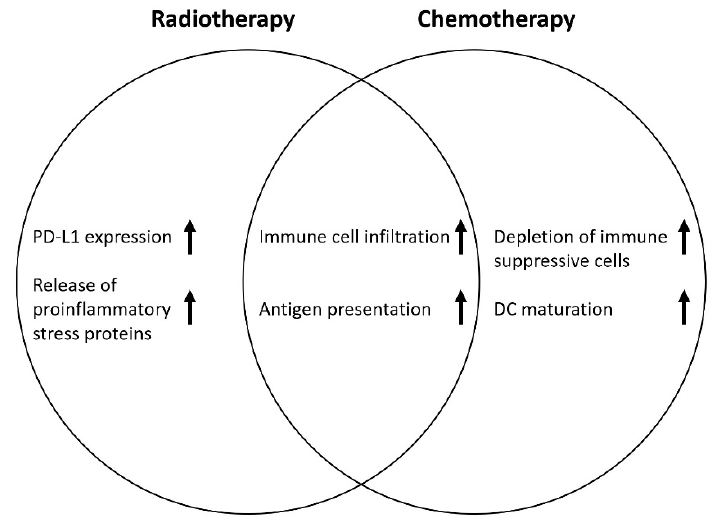
Figure 1. Proposed synergistic effects on the TME of RT and CT on ICI treatment. DC: dendritic cell maturation.